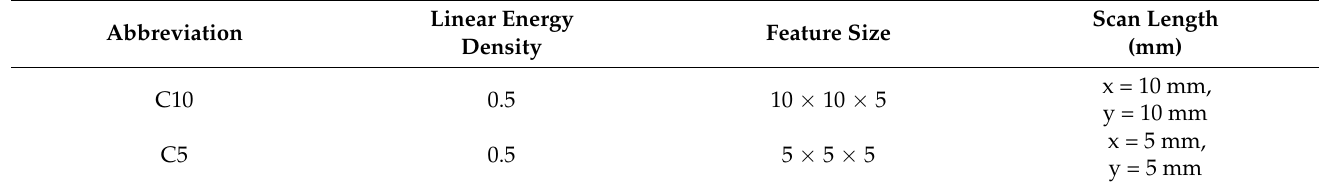
Table 1. Abbreviations and corresponding linear energy, feature size, and scan lengths of Cr specimens fabricated by LPBF.